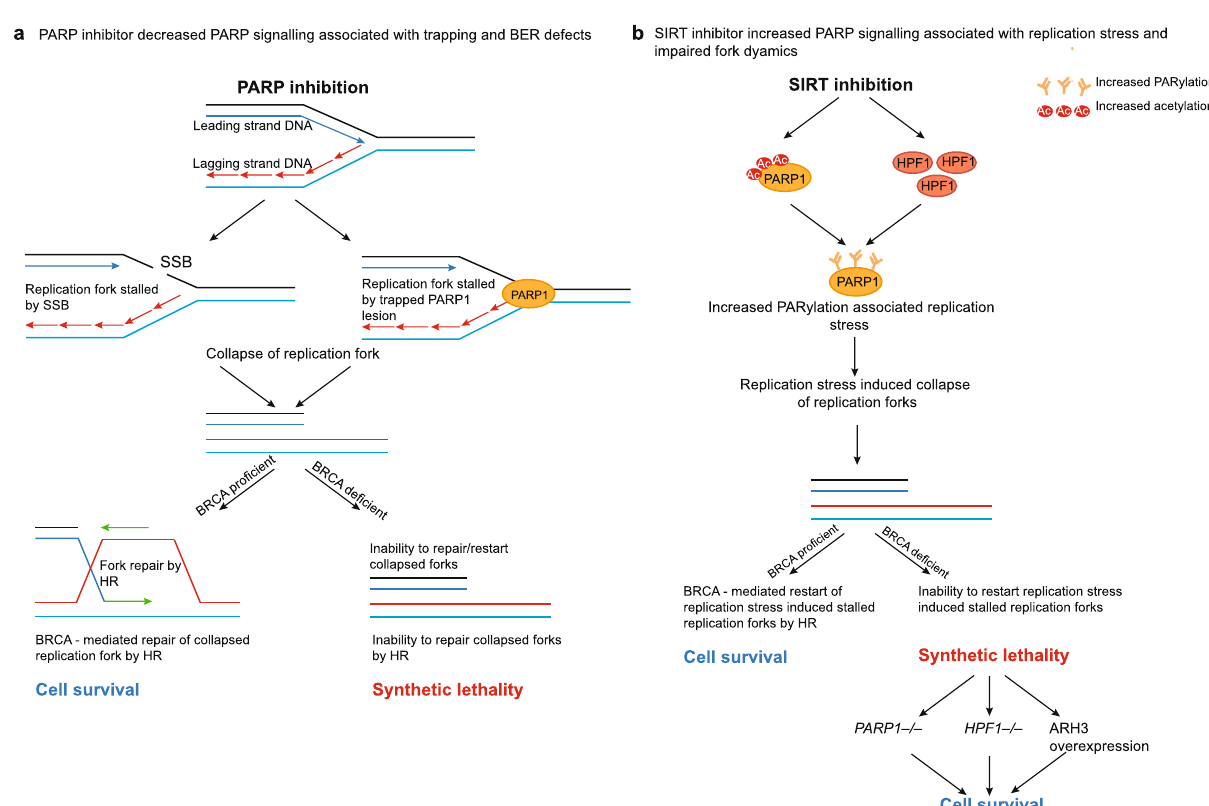
Fig. 7 Model of SIRT/ BRCA -gene synthetic lethality. a PARP inhibitors impair SSB repair and also trap PARP1 on DNA, this latter lesion being a major driver of BRCA -gene synthetic lethality, as shown. b SIRT inhibitors prevent the normal deacetylation of PARP1, leading to increased PARP1/HPF1 activity. SIRT inhibitors also increase replication fork dysfunction in BRCA -gene mutant cells, a likely driver of the synthetic lethality. Genetic deletion of PARP1 or HPF1 reverses the synthetic lethal effect of SIRT inhibitors, as does ectopic expression of ARH3 a PAR hydrolase, which normally degrades serine ADP- ribosylated chains; taken together these observations implicate the serine ADP-ribosylation activity of PARP1/HPF1 as being a causative feature of this synthetic